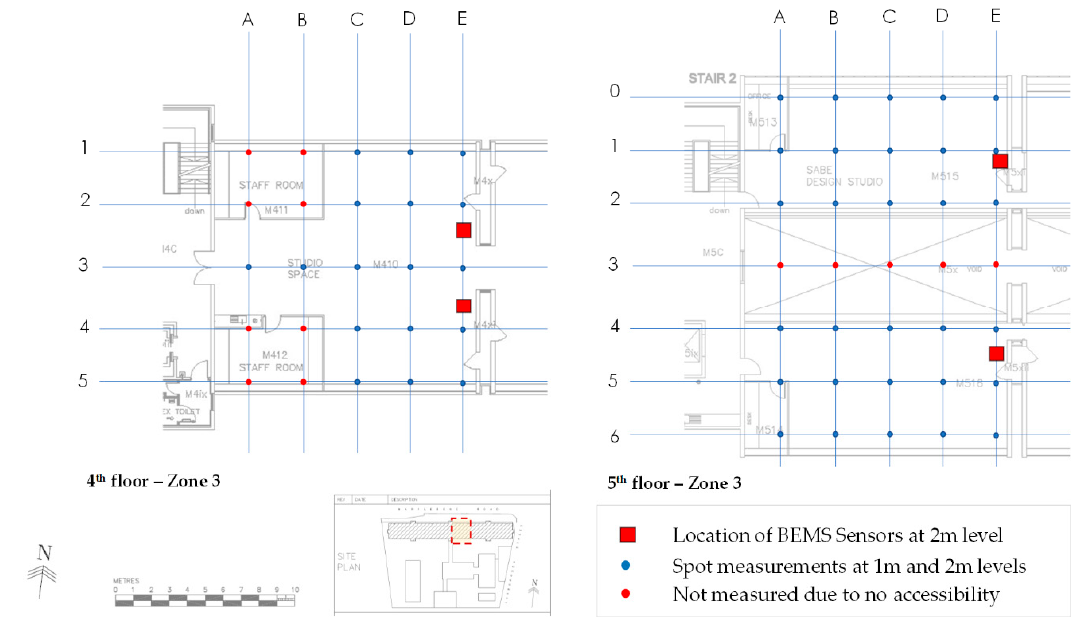
Figure 4. Grids showing the location of spot measurements on the 4th and 5th floors.